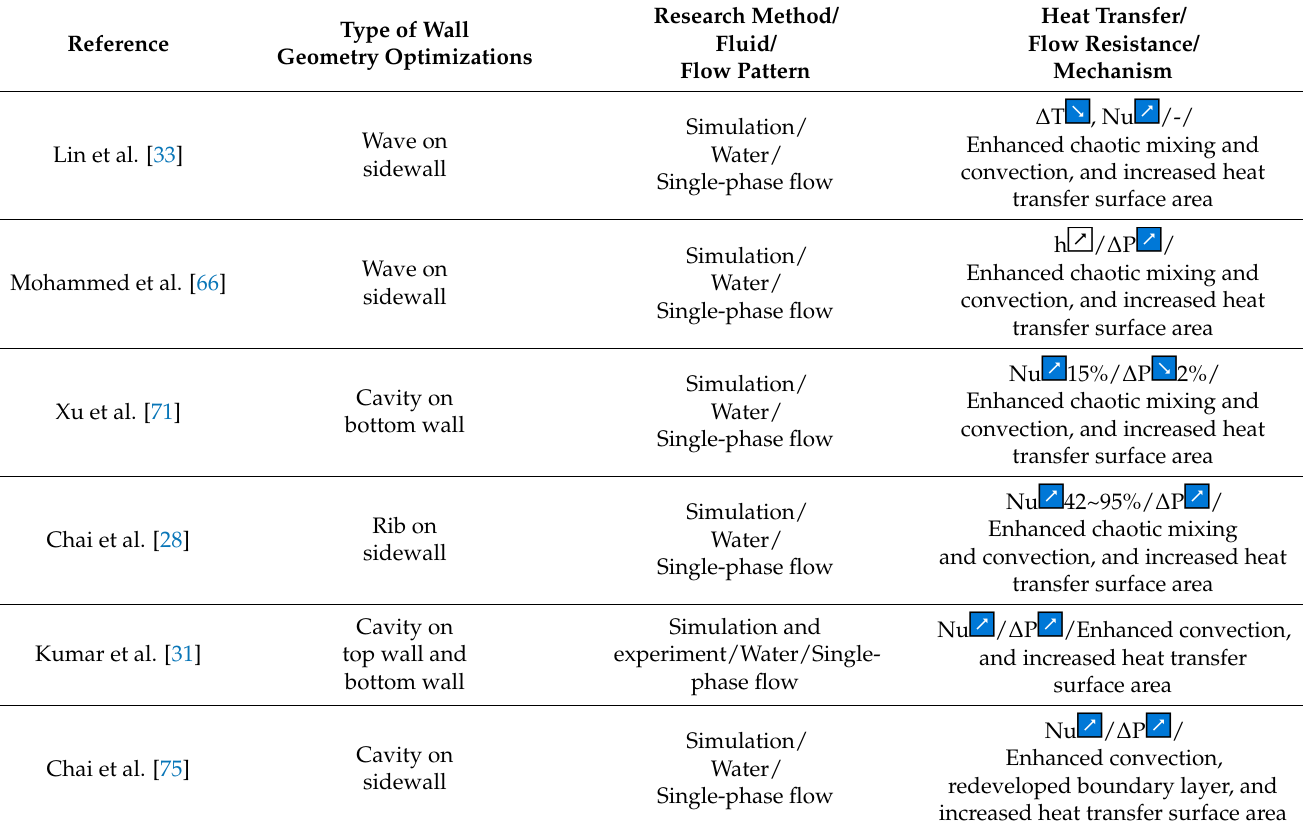
Table 3. Selected studies of geometric optimization on sidewall and bottom wall of the microchannel on heat transfer.